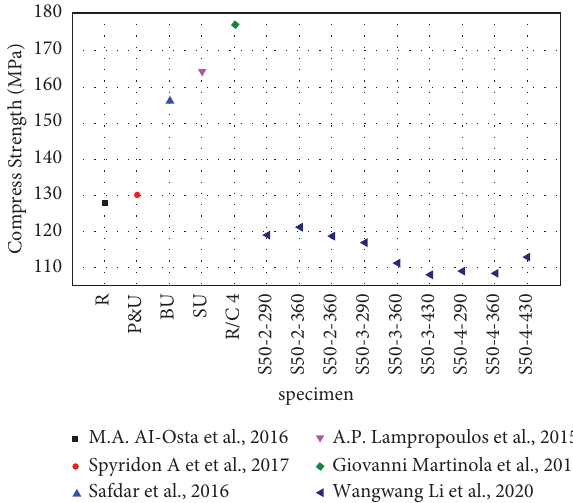
Figure 1: Te distribution of UHPC compressive stress.